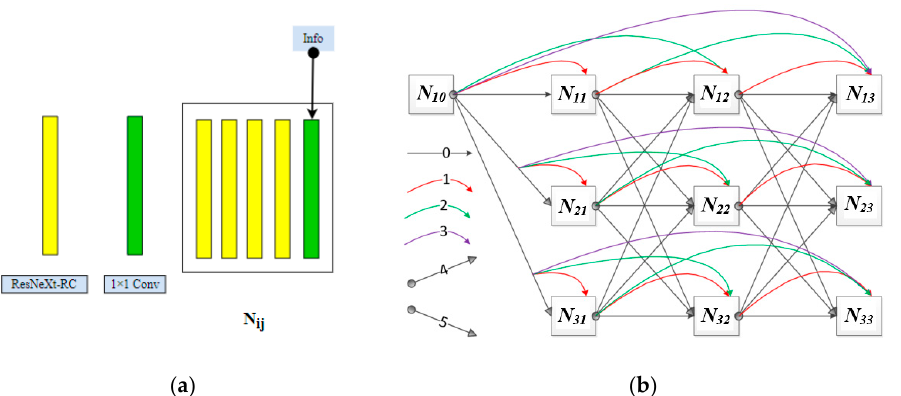
Figure 2. ( a ) Design of the network convolution module N ij ; ( b ) multiscale parallel information exchange network structure, the IIHNet.